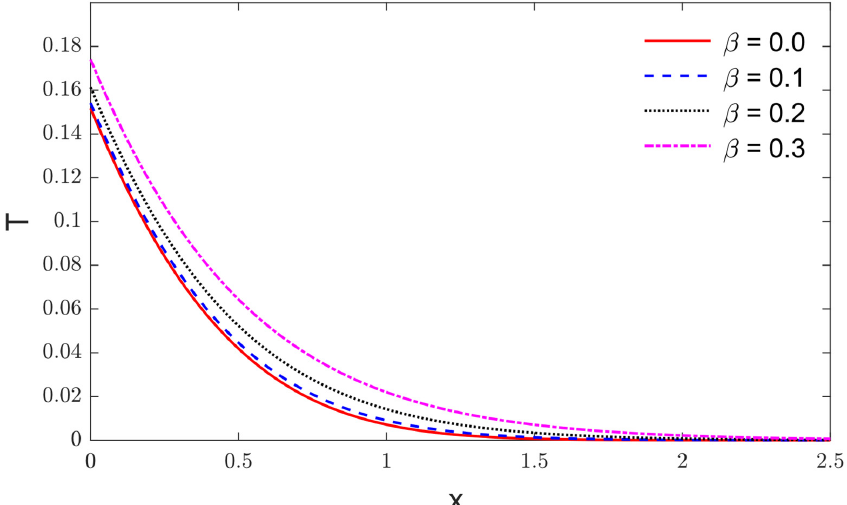
Figure 1. The impact of nonlocal parameter in the temperature variations along the distance x when α = 0.3 and τ o = 0.05.